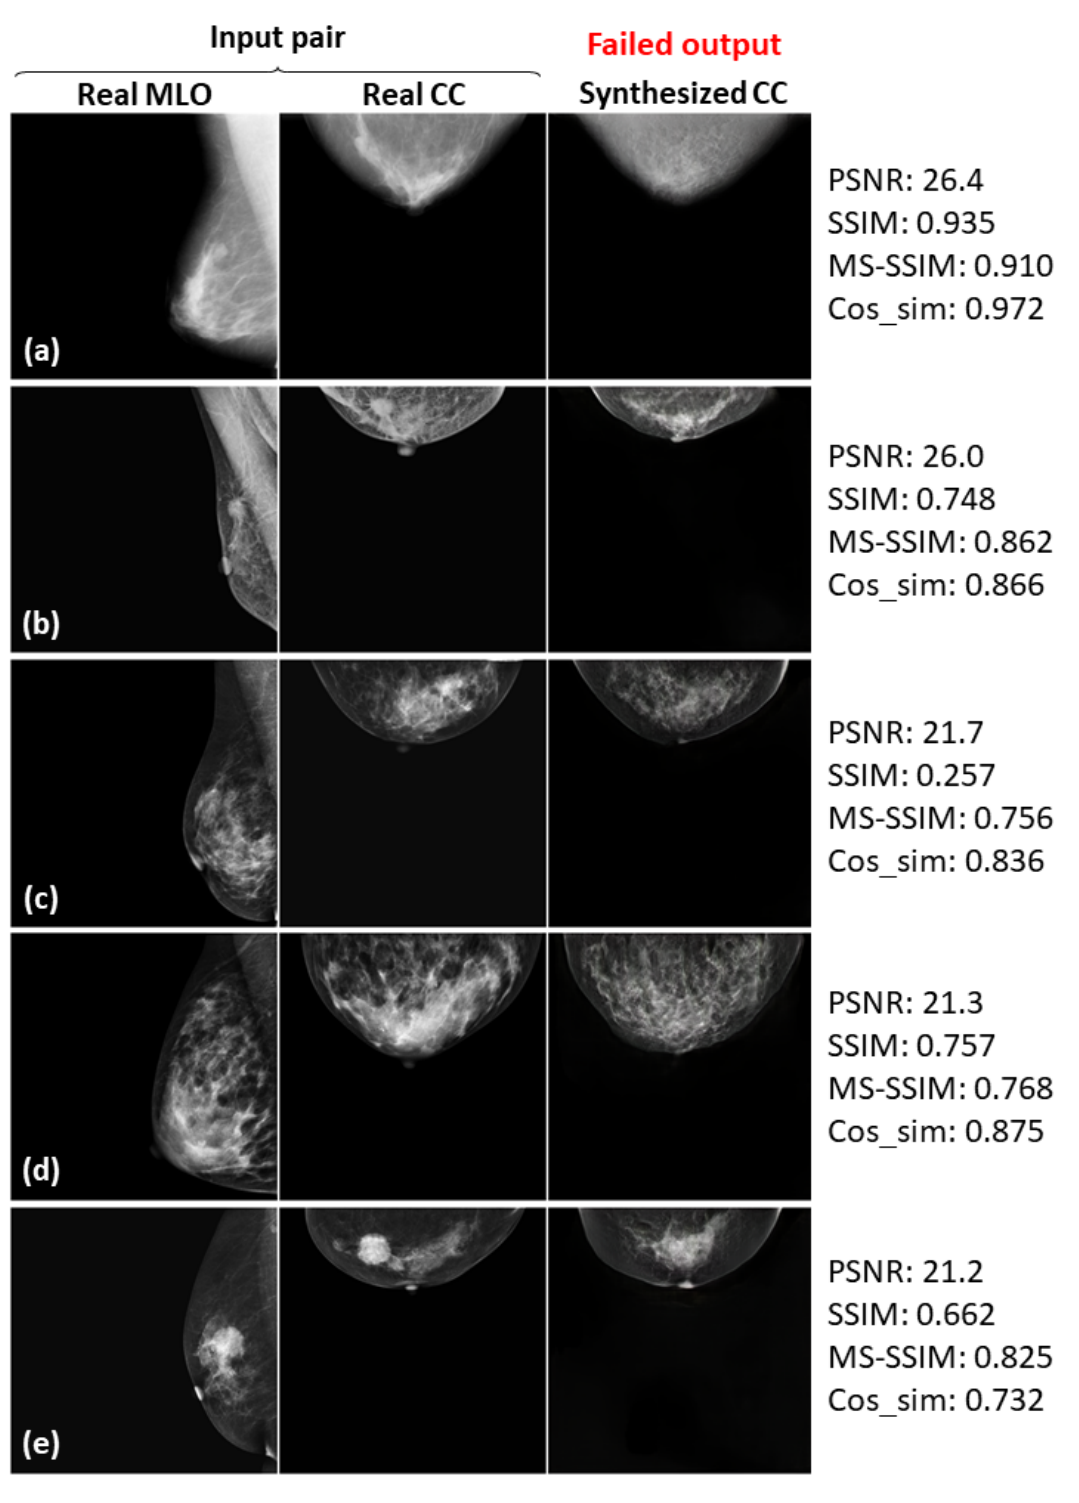
Figure 12. Five failed examples ( a – e ) of the real input paired and synthesized CC-view mammograms at 256 × 256 resolution by bi-directional training of CR-GAN incorporating PG technique and feature matching